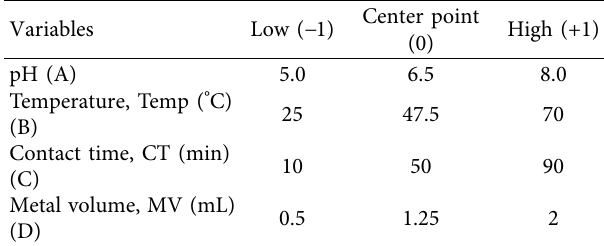
Table 1: Screened numerical variables and their low, mid-, and high